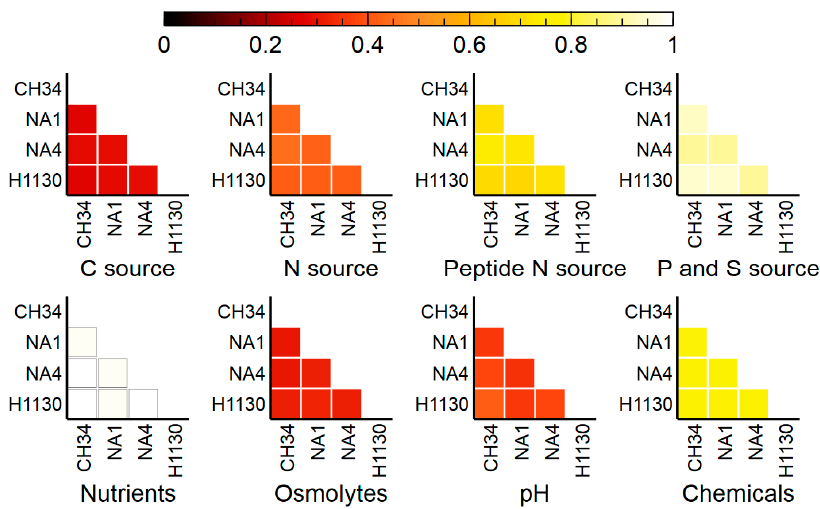
Figure 11. Overview of positive (growth) OmniLog phenotypic assays shared by C. metallidurans CH34, NA1, NA4 and H1130 for different metabolic and chemical sensitivity tests (with 1 being all assays shared).